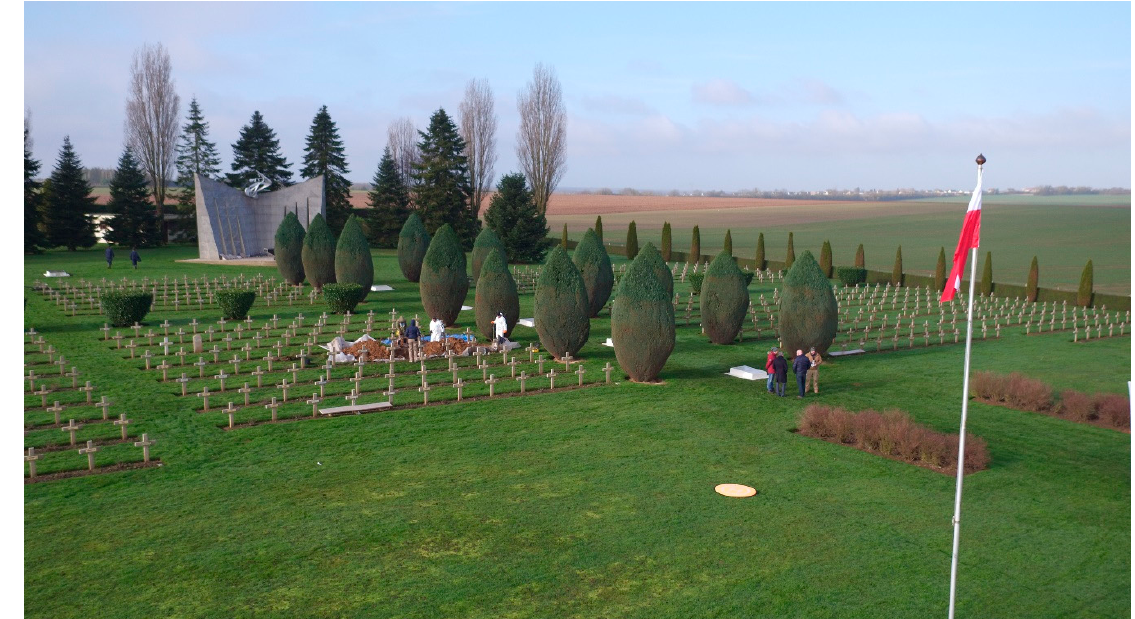
Figure 1. Exhumation site at the Polish War Cemetery in Grainville-Langannerie.